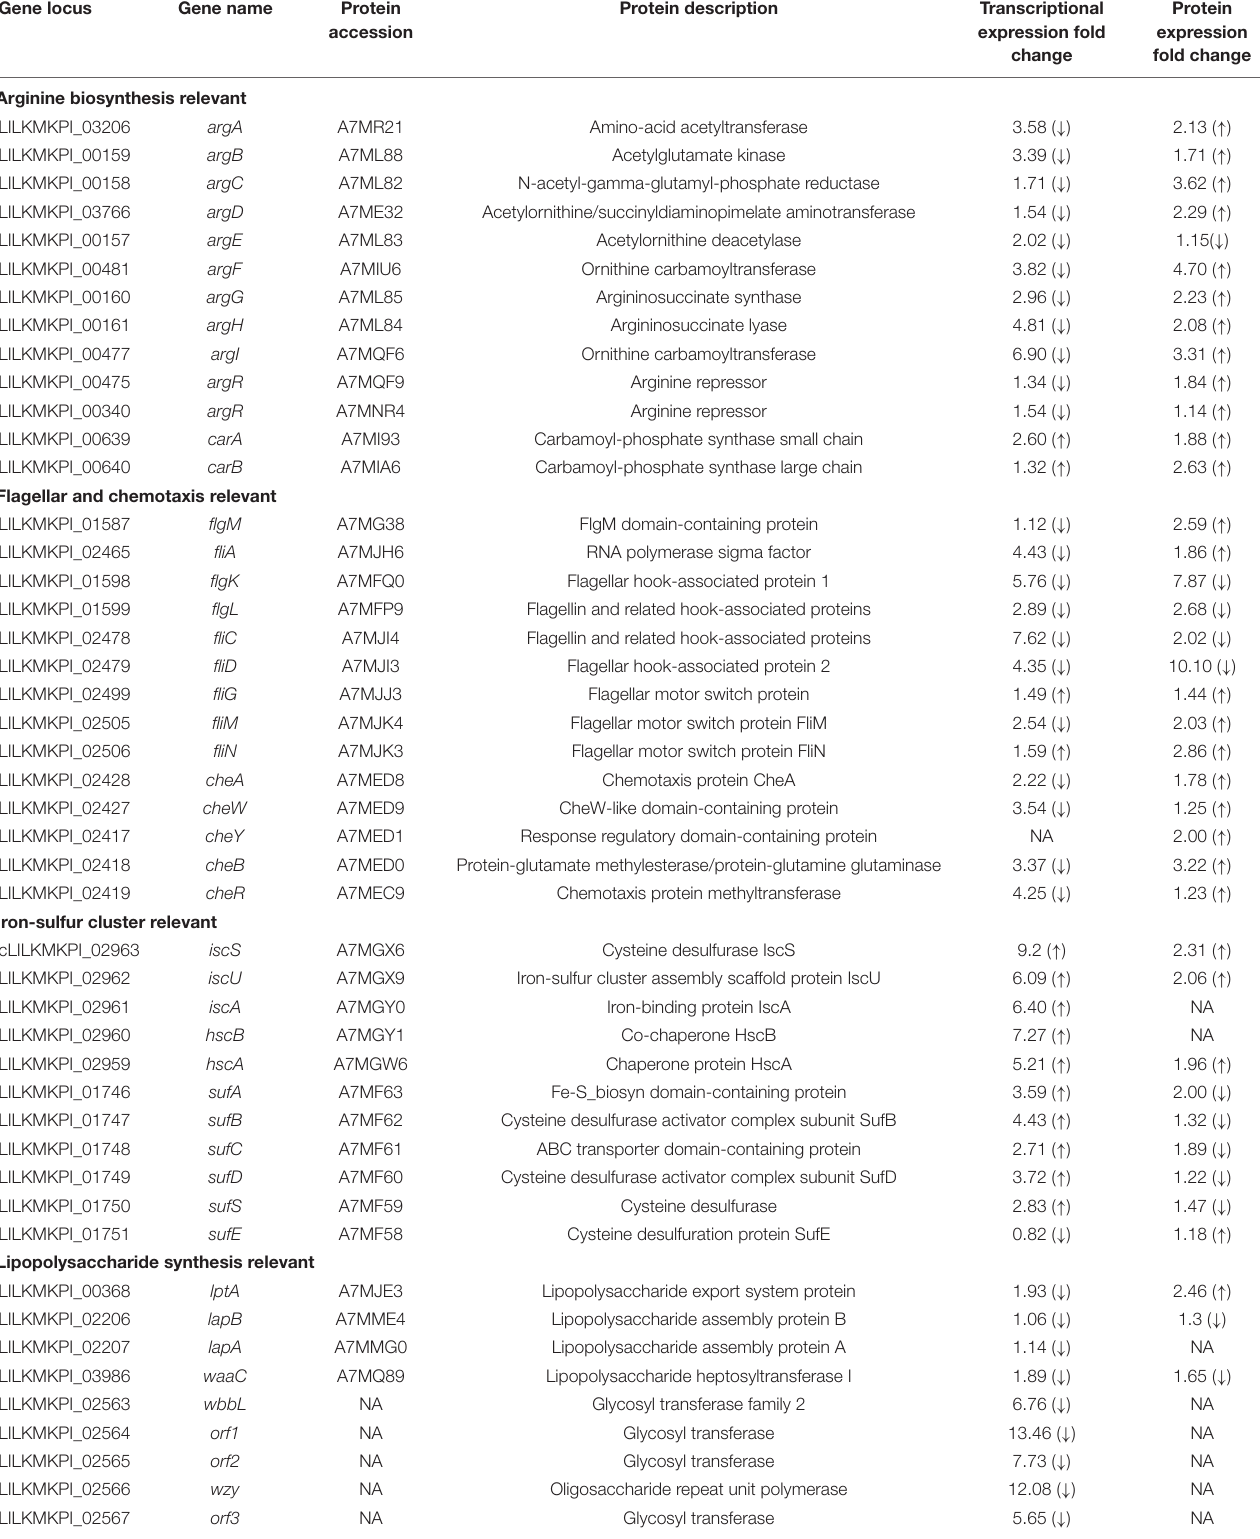
TABLE 2 | Transcriptional and protein expression changes of proteins involved in maltose/maltodextrin metabolism, ABC transporters, and arginine biosynthesis in desiccated C . sakazakii G4023. Gene